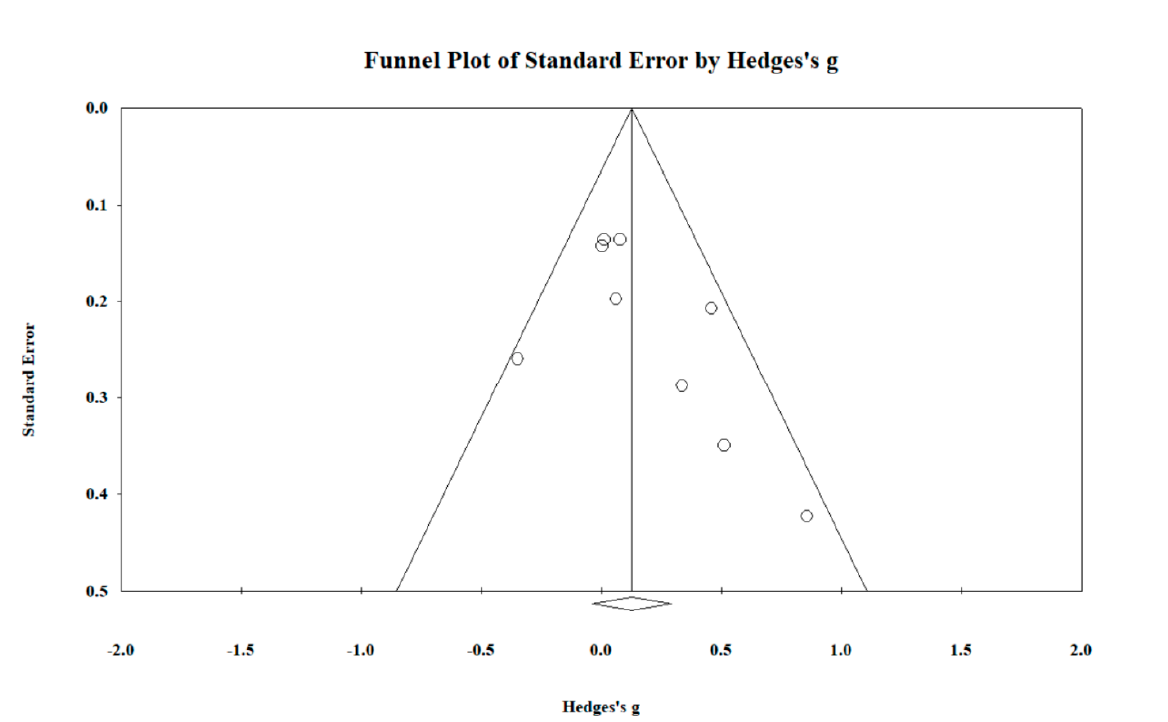
Figure A1. Funnel plot of Hedges’ g vs standard error for Stroop effect.